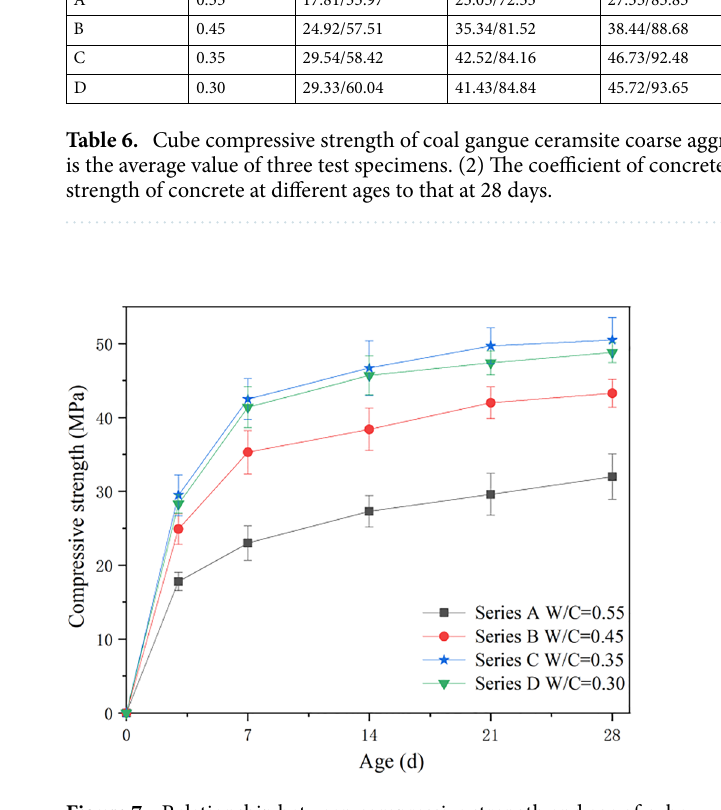
Figure 7. Relationship between compressive strength and age of